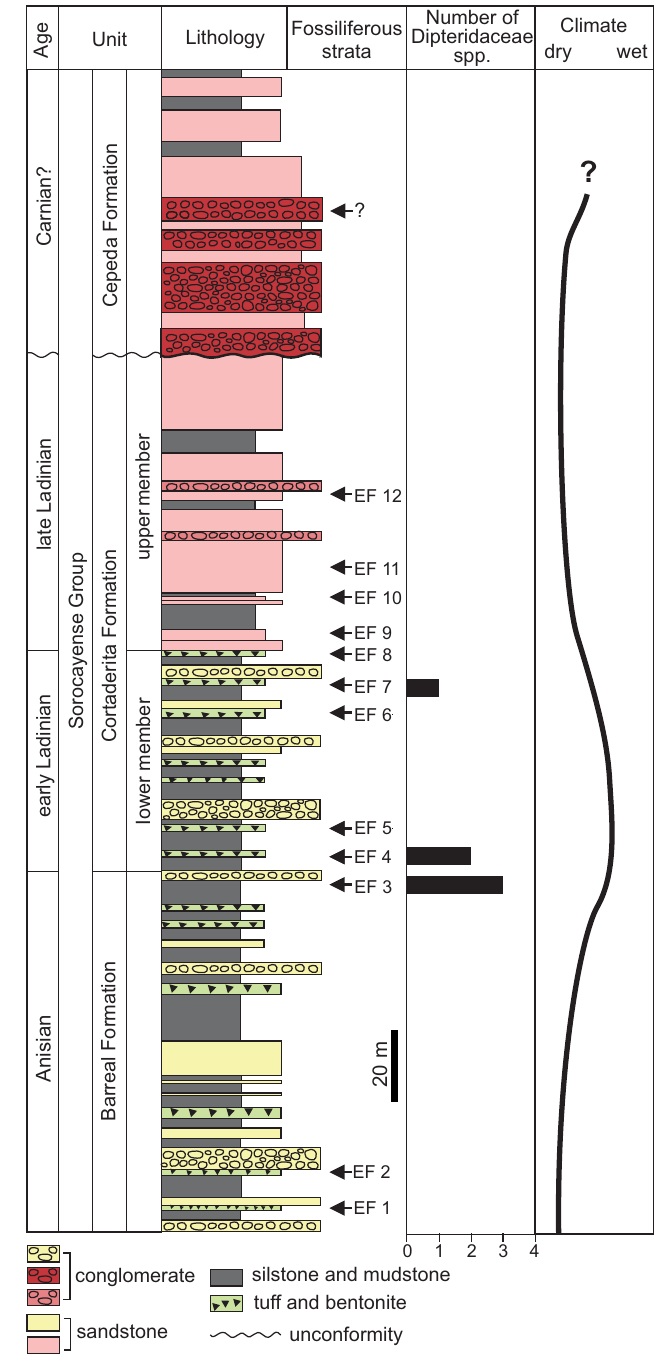
Fig. 2. Sedimentological section of the Sorocayense Group (Middle–Late Triassic) in the Barreal area (Cortaderita and La Tinta creeks), showing the stratigraphic distribution of the dipterid ferns and their correlation with the inferred